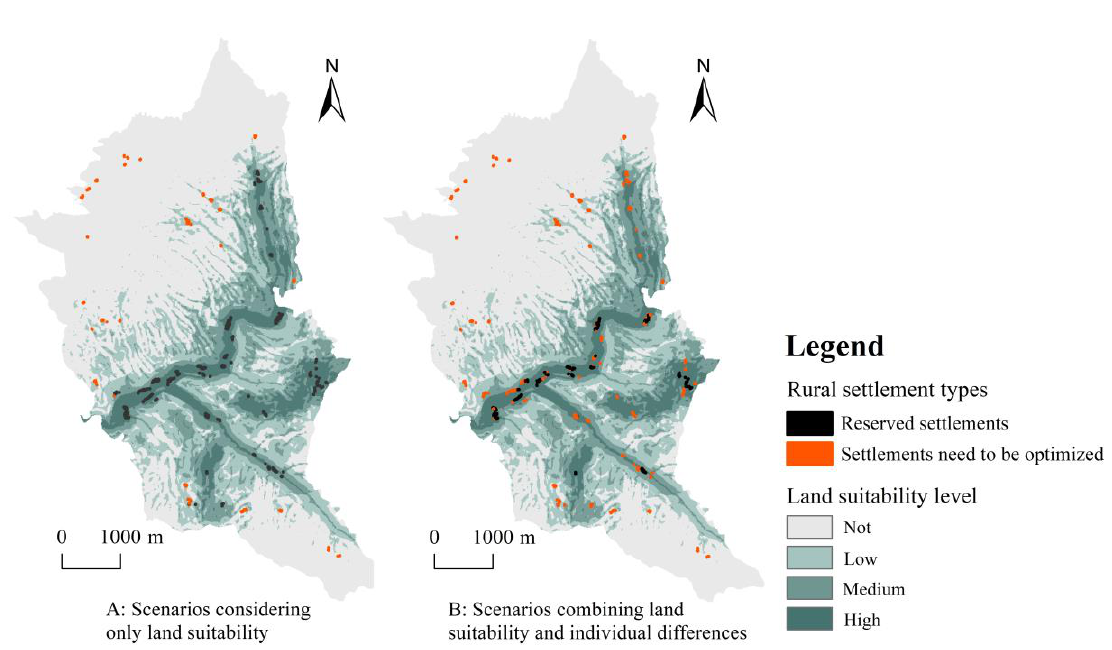
Figure 5. Changes in the distributions of different types of rural settlements before and after considering individual differences.